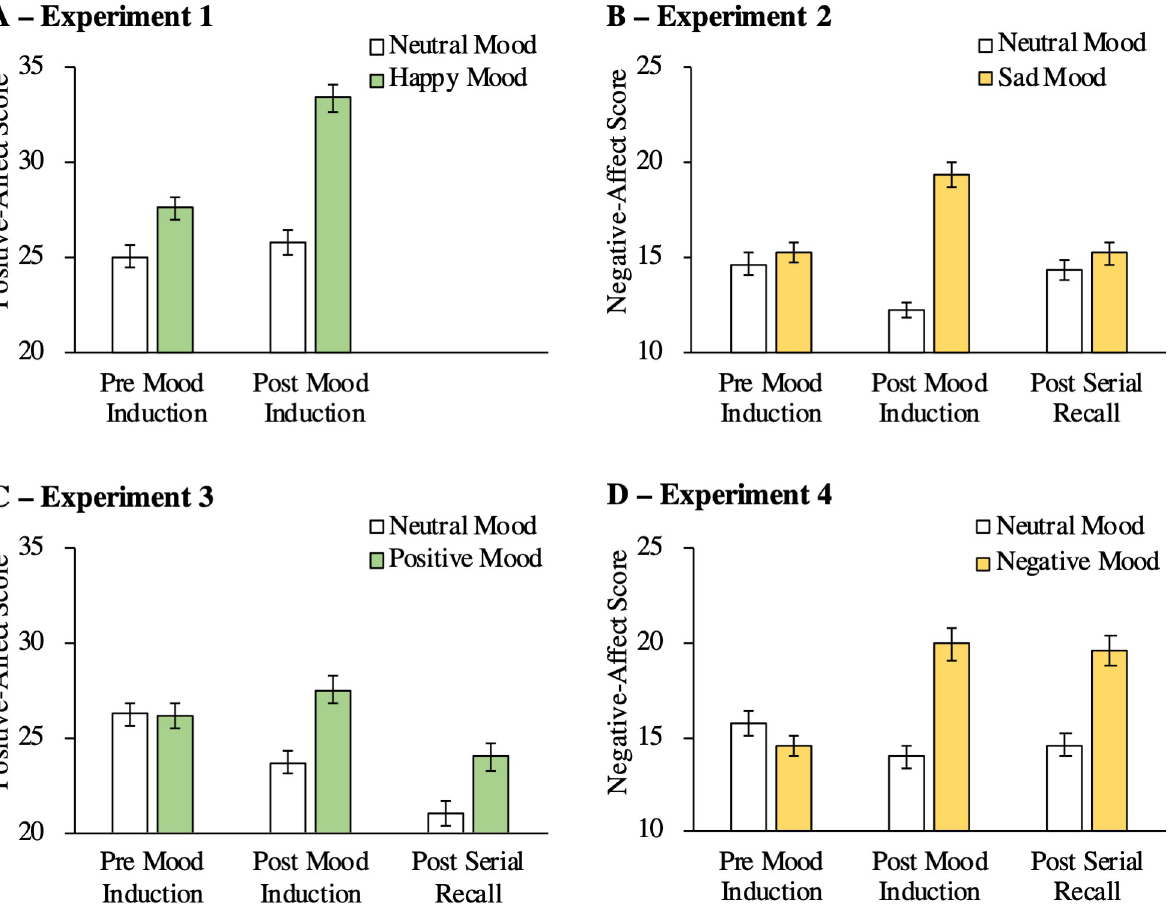
Fig 2. Mean PANAS scores as a function of induced mood and time of testing. PANAS scores can range from 10 to 50 points. The error bars represent the standard errors of the means. (A) Positive-affect scores of Experiment 1. (B) Negative-affect scores of Experiment 2. (C) Positive-affect scores of Experiment 3. (D) Negative-affect scores of Experiment